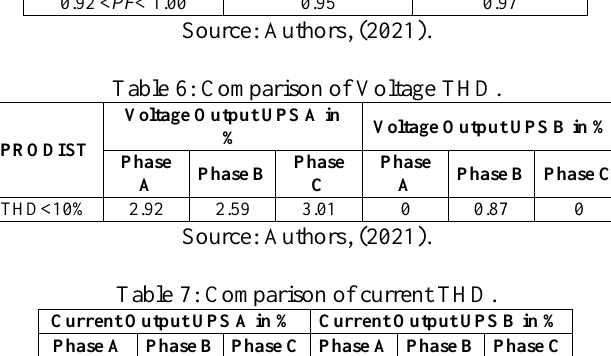
Table 5: Comparison of PF. PRODIST